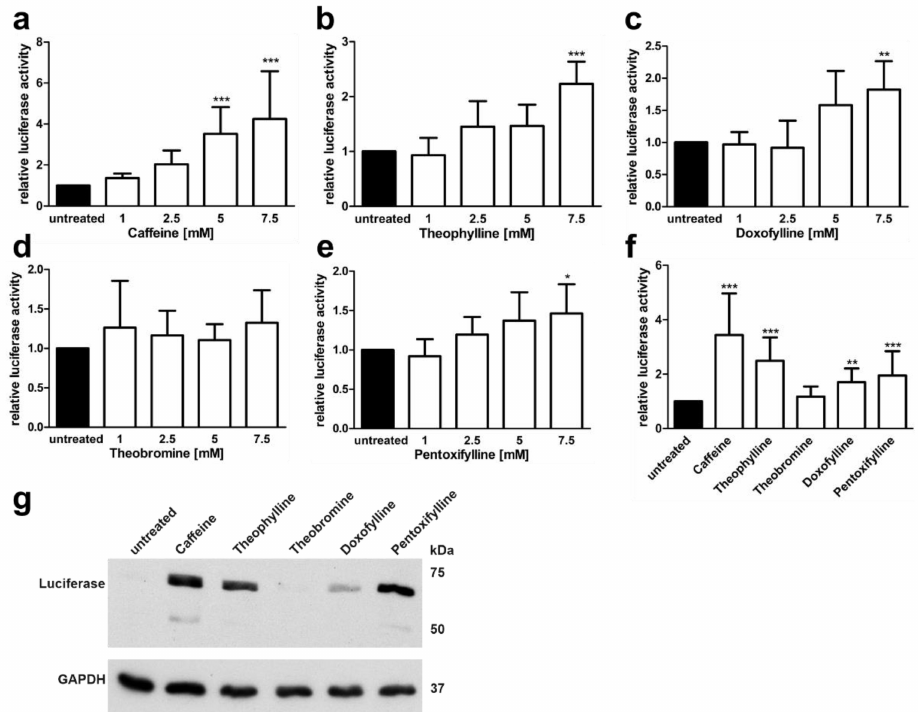
Figure 5. AGA -Minigene-luciferase splicing assay in HEK293T cells: Effect of methylxanthines. ( a – e ) HEK293T cells were transfected with the AGA -minigene construct and treated with increasing amounts of the substances for 24 h. ( f ) The cells were treated with 7.5 mM of each substance. Relative luciferase activity (firefly/renilla luciferase) of the untreated samples was set as 1. Bars represent the mean ± SD of at least five independent experiments. Statistical analysis by one-way ANOVA against the untreated samples. Values of p < 0.05 were considered significant (*) while values of p < 0.01 were considered very significant (**) and p < 0.001 extremely significant (***). ( g ) Protein lysates from ( f ) were analyzed by SDS-PAGE and Western blot. Luciferase expression corresponds to the luciferase activity seen in ( f